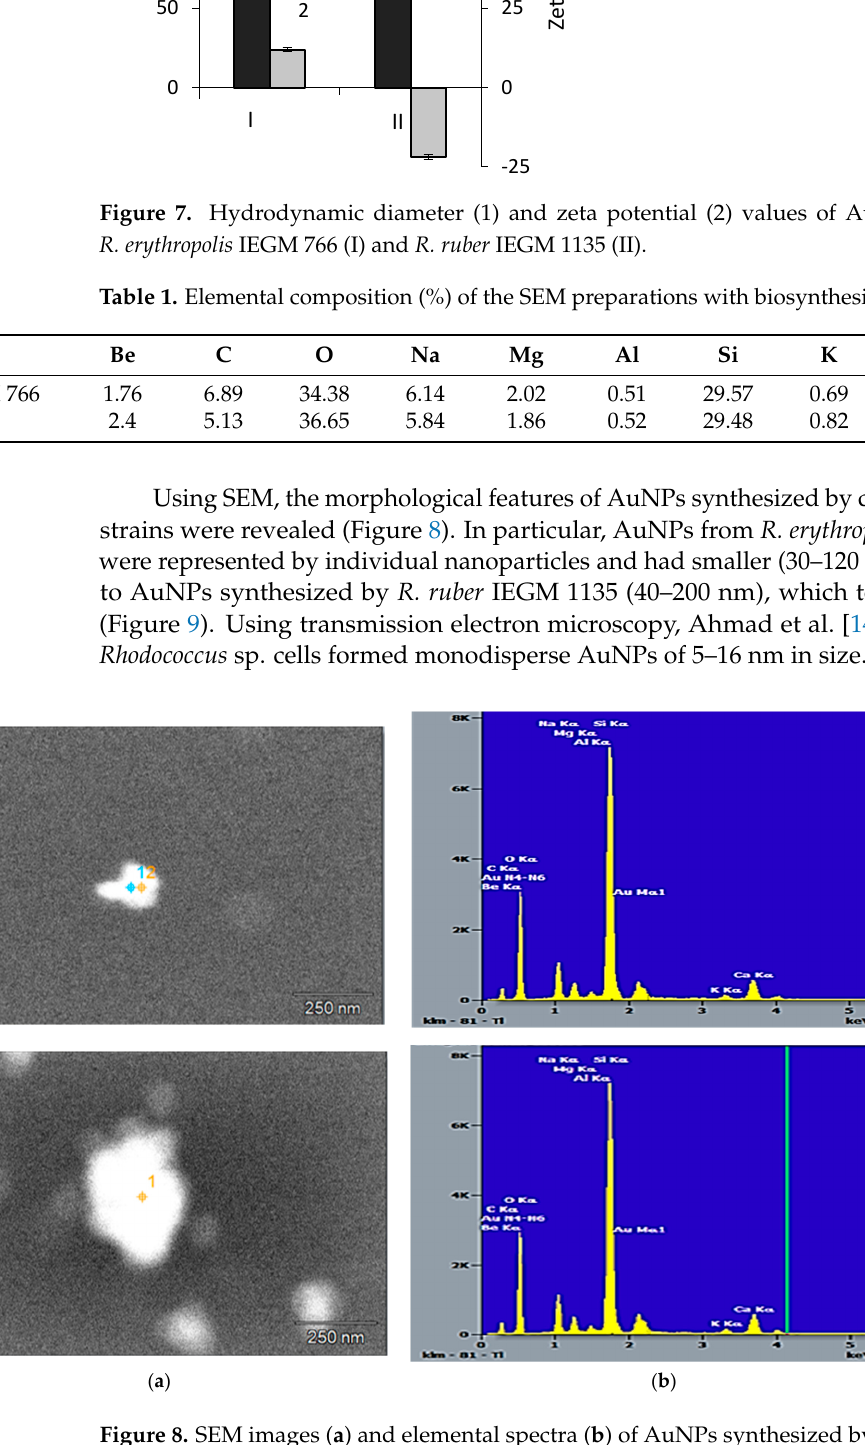
Figure 9. The SEM image shows aggregates of AuNPs (white color) synthesized by R. ruber IEGM 1135. 2.3. Antimicrobial Activity of Biosynthesized AuNPs As shown in Figure 10, the obtained AuNPs had significant antimicrobial effects on the bacterial cultures tested. In particular, a 65% decrease in cell viability of E. coli ATCC 25922 and a less pronounced (by 51 and 18%) suppression of M. luteus IEGM 401 were revealed upon exposure to AuNPs synthesized by R. erythropolis IEGM 766 and R. ruber IEGM 1135, respectively. Another research group [9] also showed the inhibiting effect of AuNPs obtained from Deinococcus radiodurans on Gram-negative rather than Gram-posi- tive bacteria, which, apparently, is due to differences in the cell wall structure.